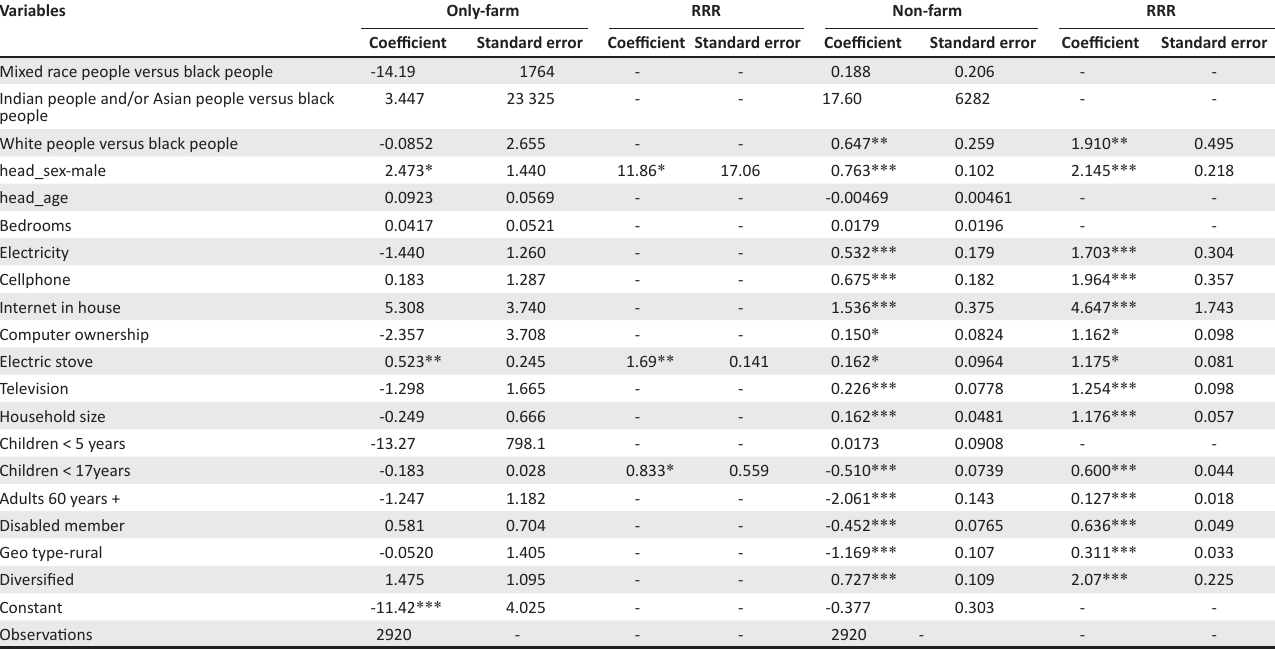
TABLE 7: Multinomial regression: Livelihood strategies.